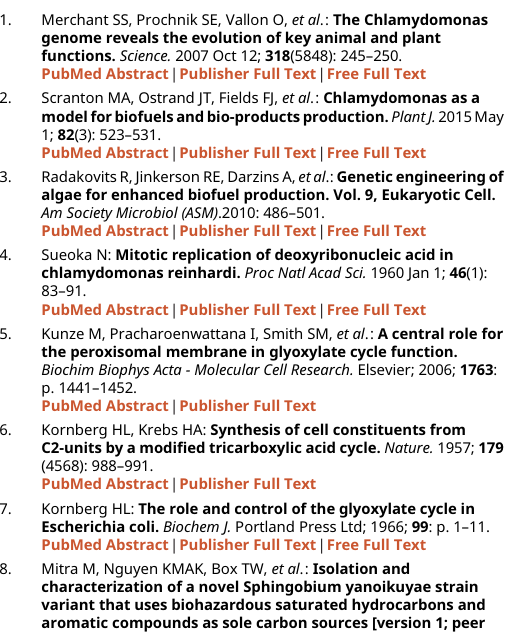
Figshare: Image of the DNA agarose gel showing the electrophoretic analysis of PCR products obtained using the 16S rRNA gene-specific primers on Clip185/ Microbacterium binotii strain PK1-12M variant (Accession number: MN633284.1) genomic DNA, https://doi.org/10.6084/m9.figshare.14669400. 42